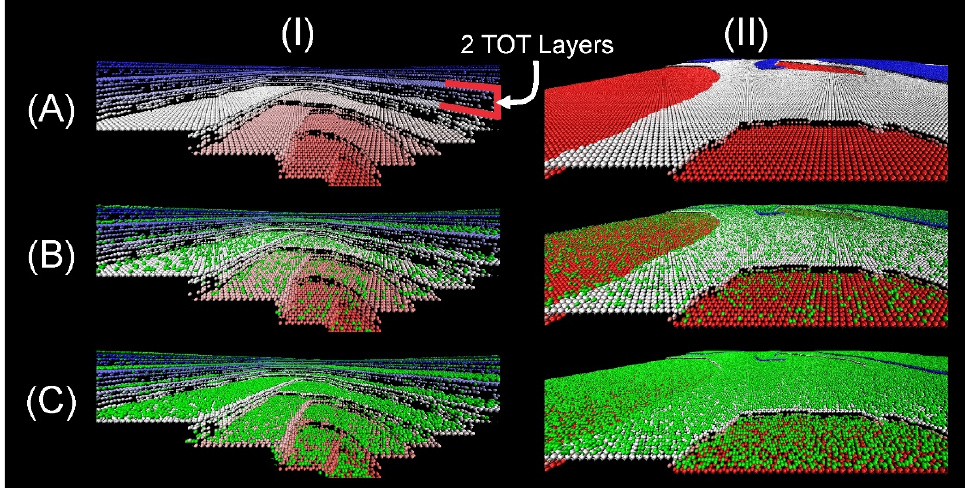
Figure 3. Perspective view of ( I ) the deepest part of the single etch pit and ( II ) the three top left etch pits. The view direction is parallel to the lateral boundaries of the system as can be seen in Figure 2. Row ( A ) shows both surfaces before adsorption with an indication on the step height of up to two TOT layers in case ( I ), while in case ( II ), the two steps are one TOT layer each. The same color scale as in Figure 2 is used to represent the pit depth. Images in rows ( B ) and ( C ) show the distribution of adsorbed radionuclides (green) after 75.000 and 300.000 atoms identical to the time steps shown in Figure 2.